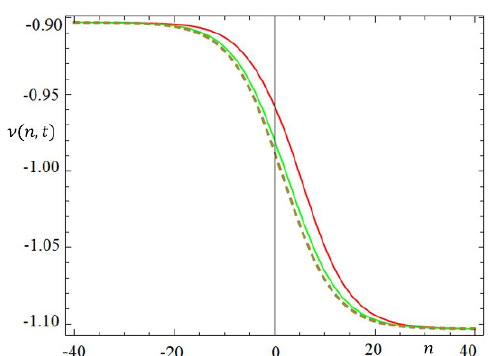
Figure 3. Explicit numerical solutions of Eq. (16) for u (40) at µ = 1 , λ = 1 . Redline µ = 1 , µ = 1 ; Dashedlinewith c = 0 . 1 , d = 0 . 1 and t = 5 . µ = 1 4 4